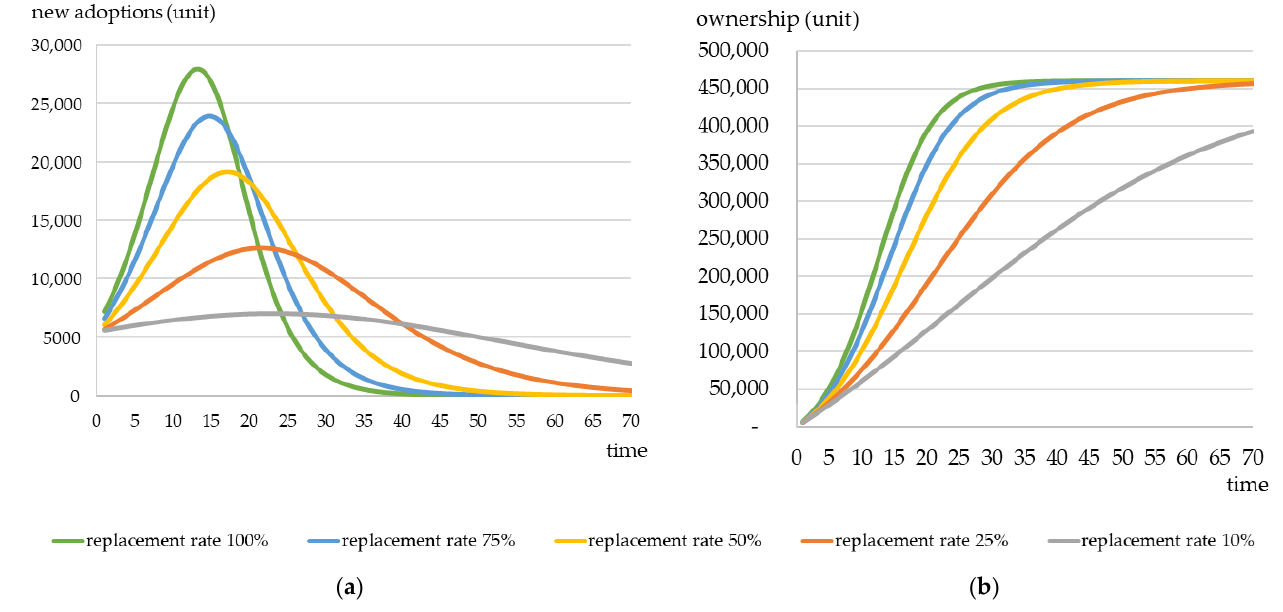
Figure 2. ( a ) Description of what is contained in the first panel; ( b ) Market ownership in the scenar- ios with 100%, 75%, 50%, 25% and 10% replacement